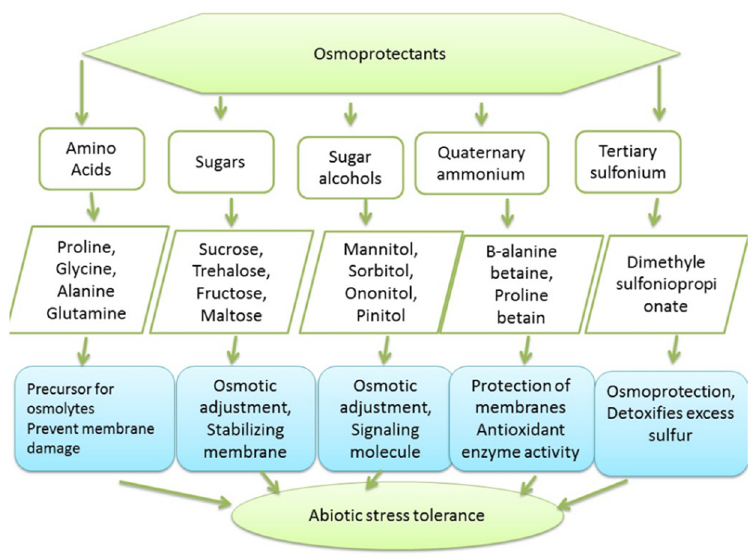
Figure 6. The role of osmoprotectants in abiotic stress tolerance. Under abiotic stress, mulate different types of osmoprotectants. These have different roles, including stabilization and plants accumulate different types of osmoprotectants. These have different roles, includ- maintenance of cell membrane composition and structure, molecular signaling, and cell ing stabilization and maintenance of cell membrane composition and structure, molecular signalling, and cell detoxification.